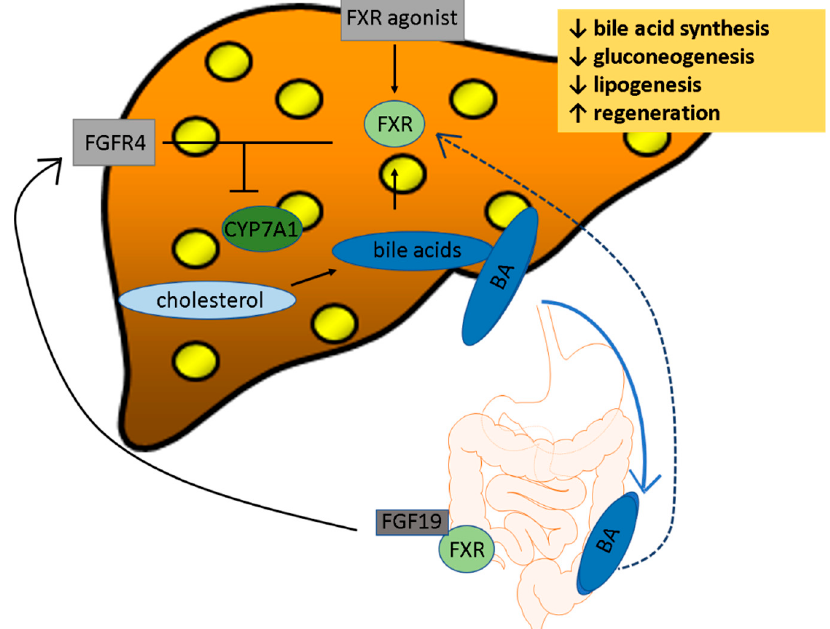
Figure 1. Illustration of how farnesoid X receptor (FXR) relation in bile acid homeostasis. FXR blocks bile acid (BA) synthesis through cholesterol 7 α -hydroxylase (CYP7A1). Additionally, bile acid synthesis is blocked via the BA-dependent intestinal fibrolast growth factor (FGF19), which activates fibroblast growth factor receptor 4 (FGFR4) in the liver. There is also a negative feedback loop from BA on FXR.